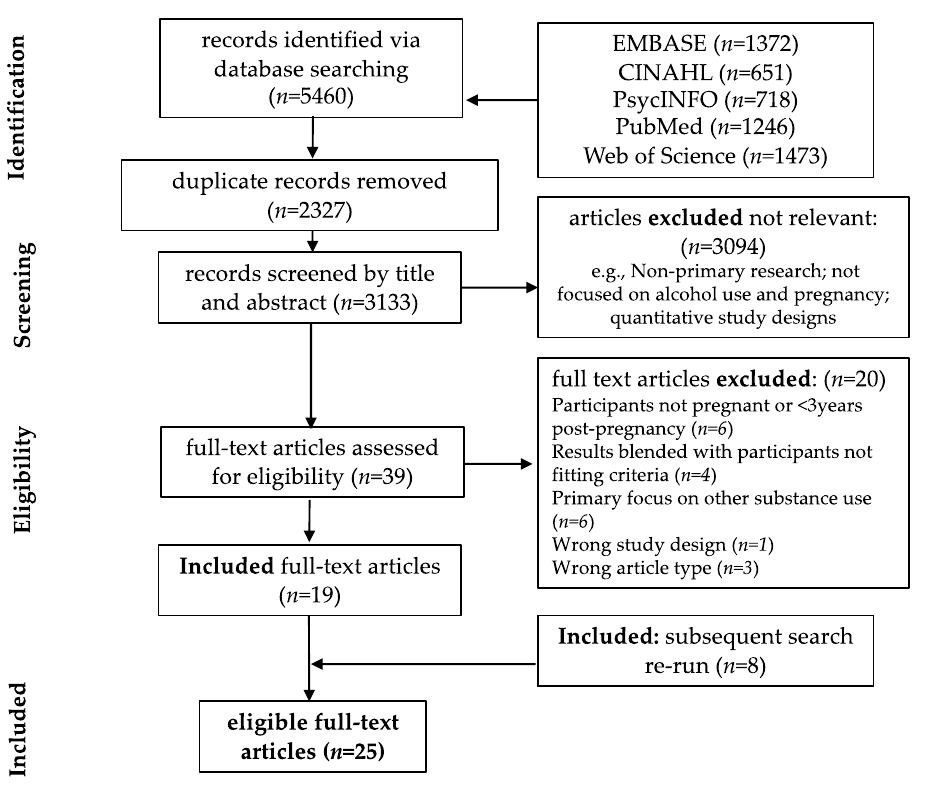
Figure 1. PRISMA Flow Chart.